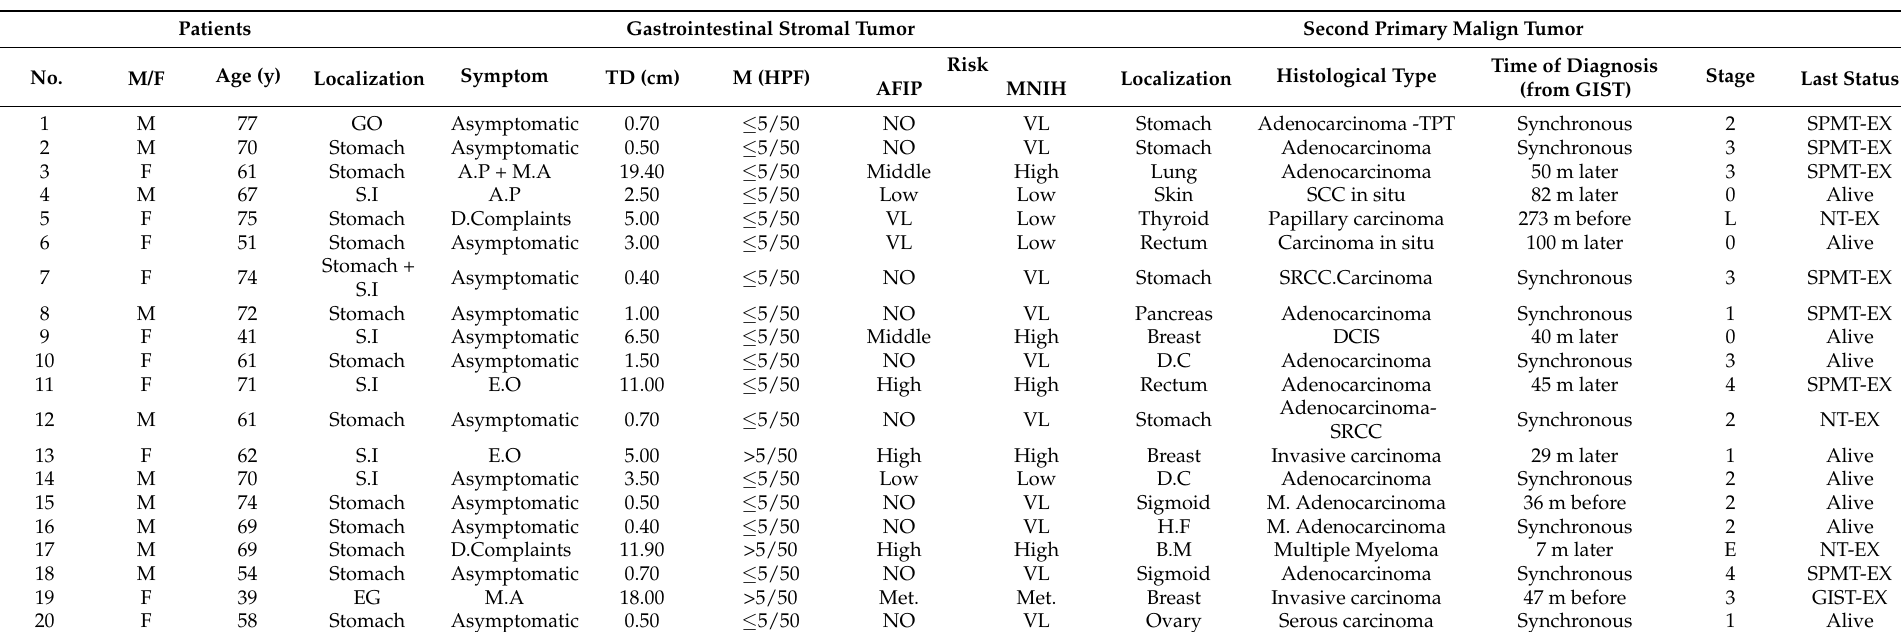
Table 3. Characteristics and survival data of GIST and